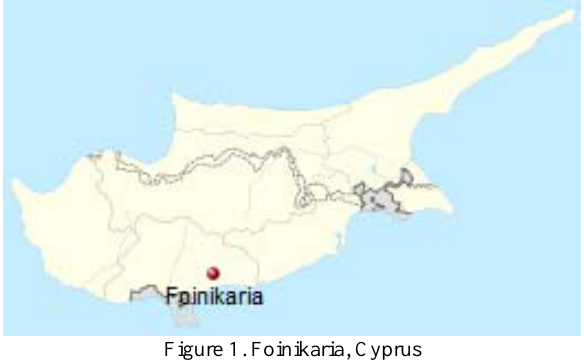
Figure 1. Foinikaria,